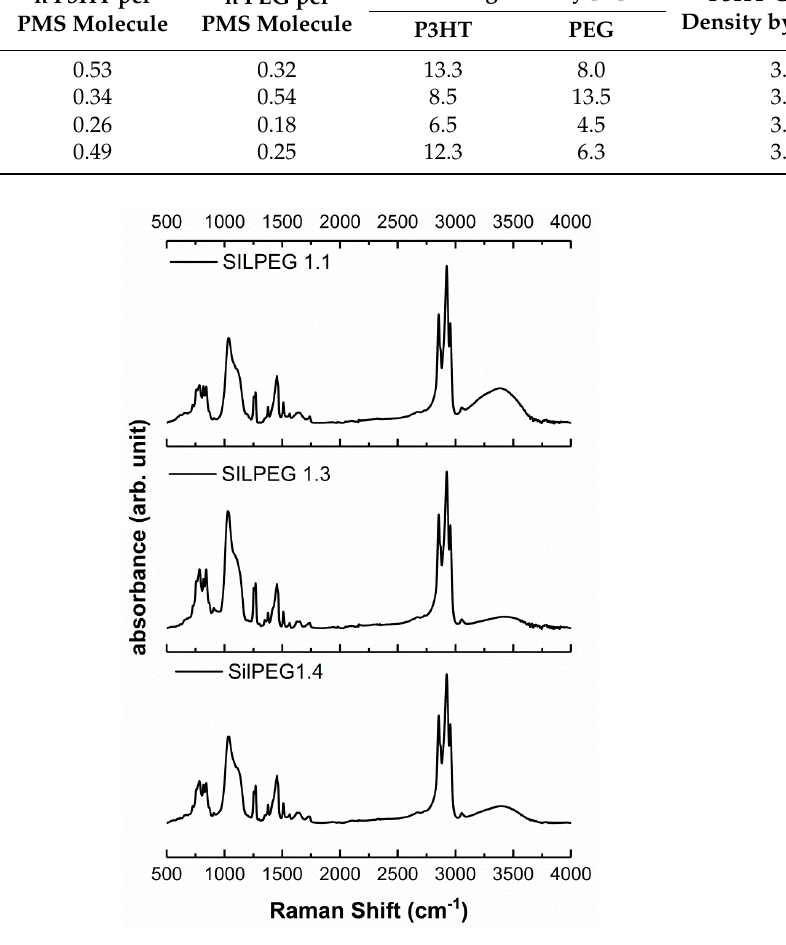
Figure A6. IR-ATR spectra of SilPEG1.1, SilPEG1.3, SilPEG1.4.